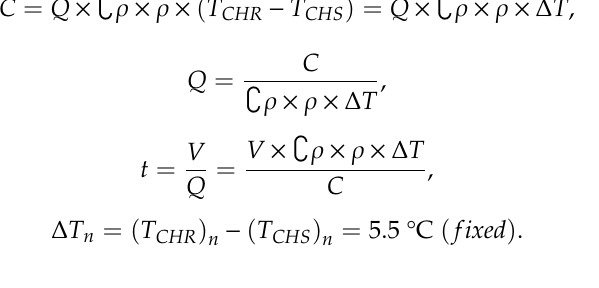
Table 5. IT cooling system for a typical